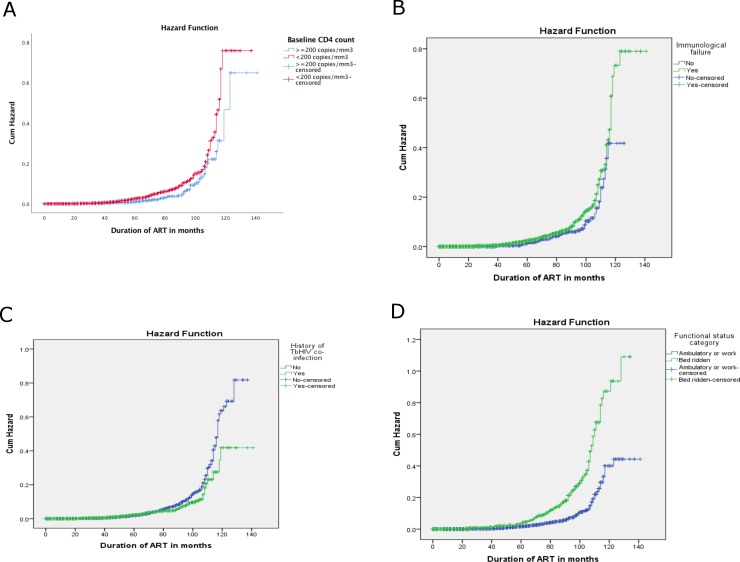
(a-d) Kaplan-Meier plot of hazard function stratified according to baseline CD4 count, immunologic failure, Tb/HIV co-infection and functional status among a cohort of ART clients respectively; JUTH hospital, Southwest Ethiopia; 2016—This figure presents the association between baseline CD4 count immunologic failure, Tb/HIV co-infection and functional status, and HIV mortality.